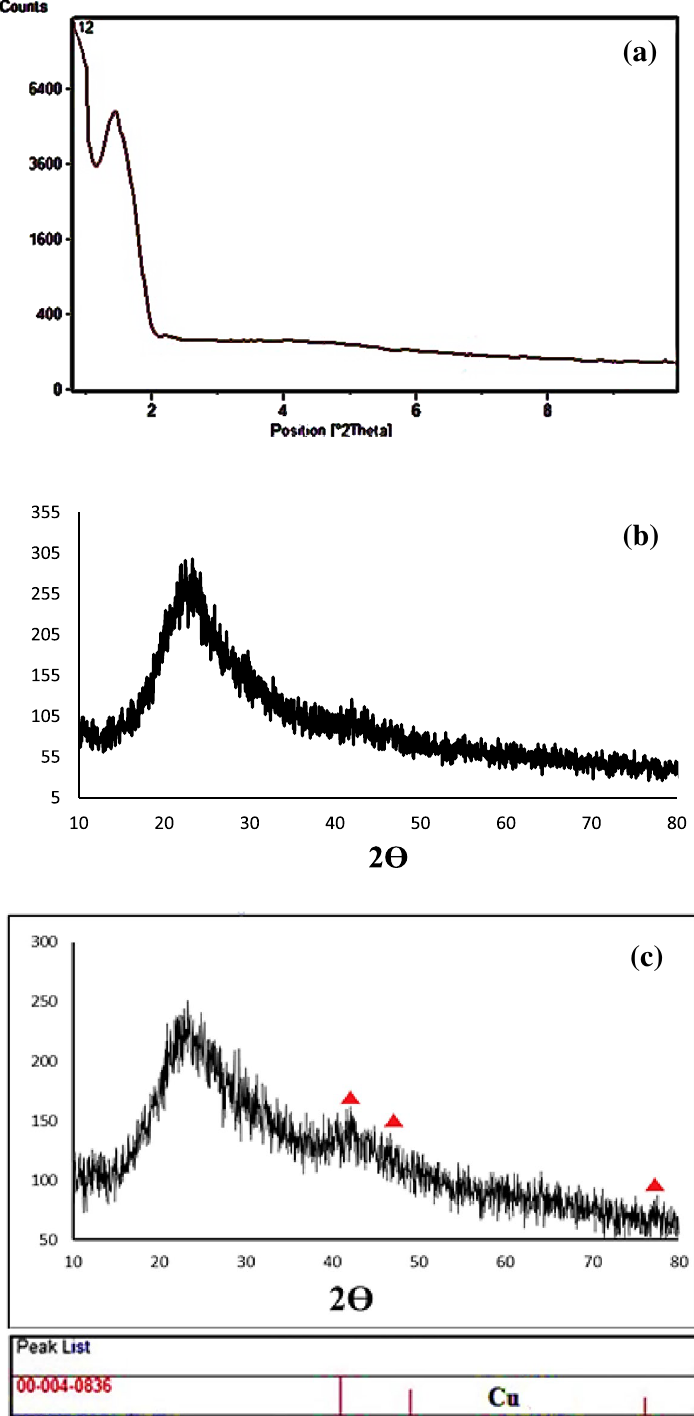
Figure 5. Low-angle ( a ) and wide angle ( b ) XRD patterns of the APS-TDU-PMO; Wide angle XRD pattern of the Cu@APS-TDU-PMO ( 1, c